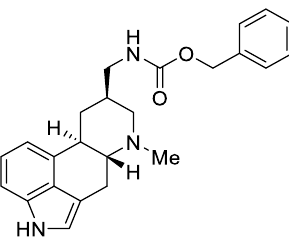
Figure 5. Metergoline.